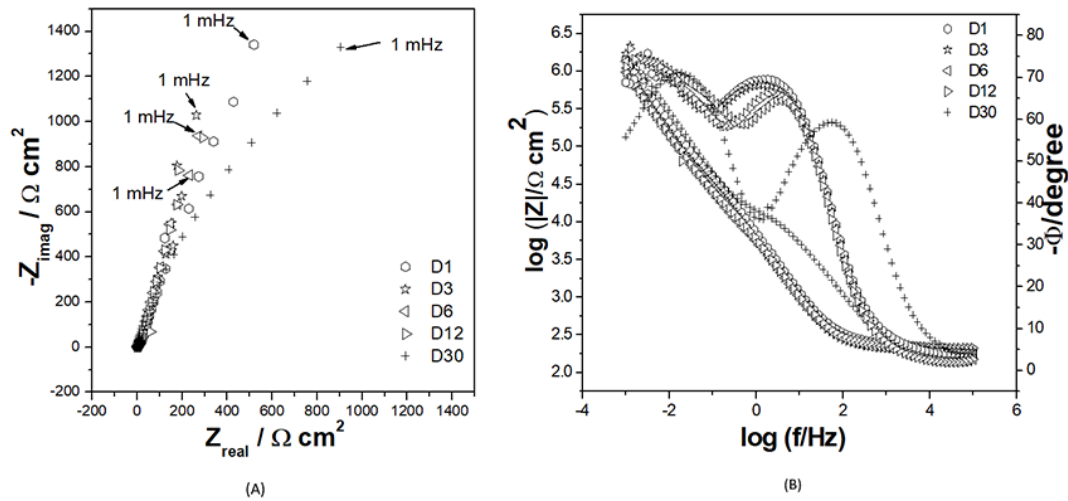
Figure 6. Experimental complex plane and Bode plots for HA sample in non-aerated and unstirred Hanks' solution without BSA for 30 days of immersion at 37 ºC: (A) complex plane plots; (B) Bode - phase angle vs . log f and impedance modulus vs . log f plots.